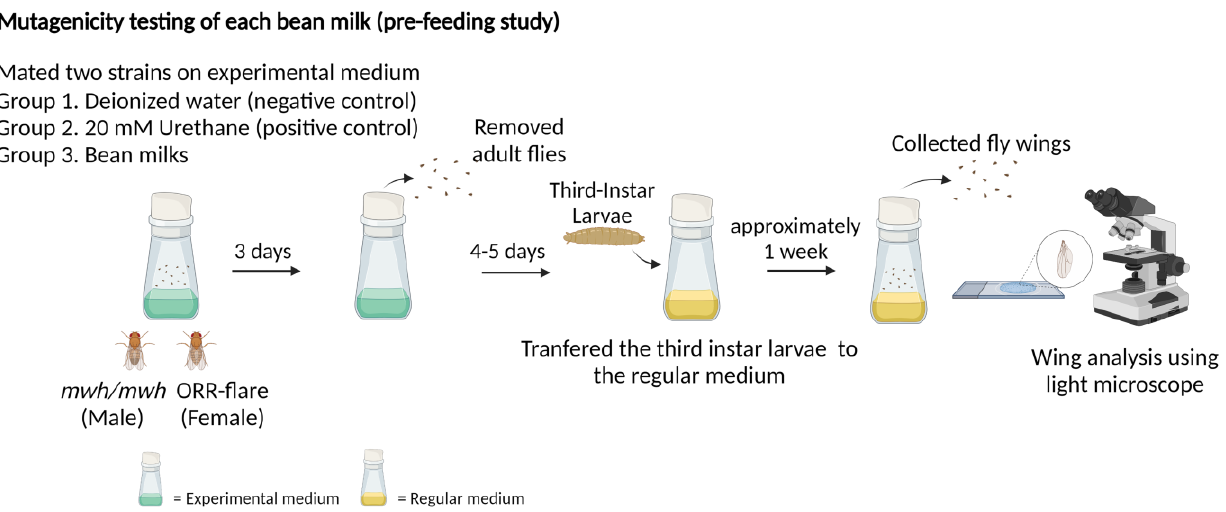
Figure 2. Experimental design of the pre-feeding study for mutagenicity testing: crossed adult flies were fed on the experimental medium containing each bean milk, water (negative control) or 20 mM urethane (positive control), and the third instar larvae were transferred to the regular medium. Wings were collected and analyzed for mutant spots. 2.3.3. Anti-Mutagenic Evaluation of Bean Extracts Using the Co-administration Study The mwh strain and the ORR strain were bred on the regular medium to produce trans-heterozygous larvae (F1 progenies). After that, one hundred of 3d old larvae were